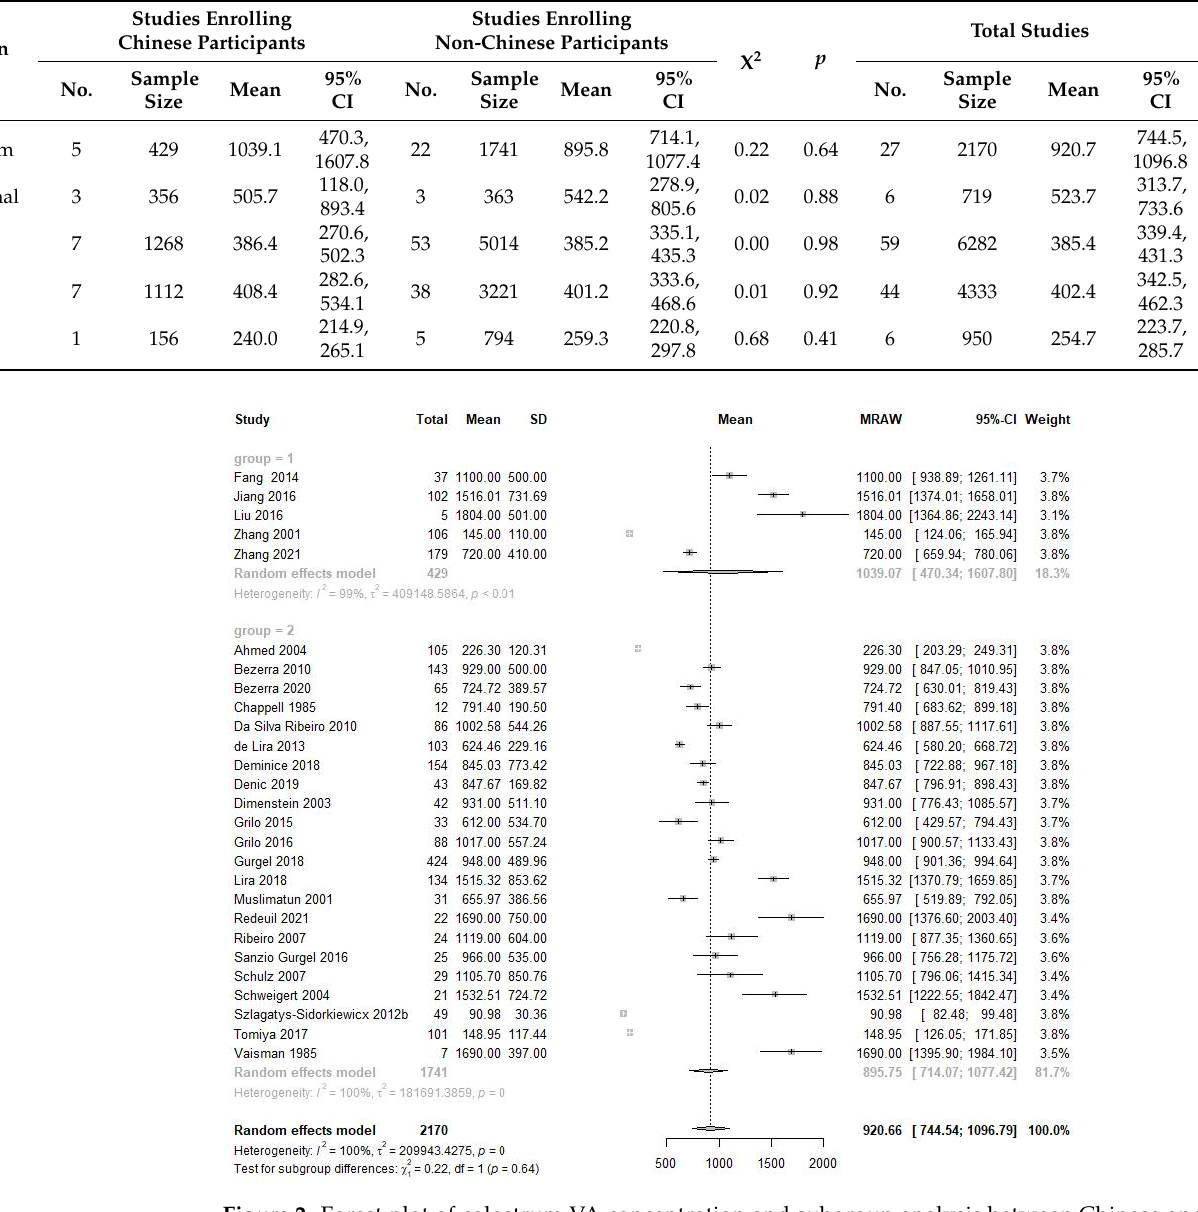
Figure 3. Forest plot of transitional human milk VA concentration and subgroup analysis between Chinese and non-Chinese samples.